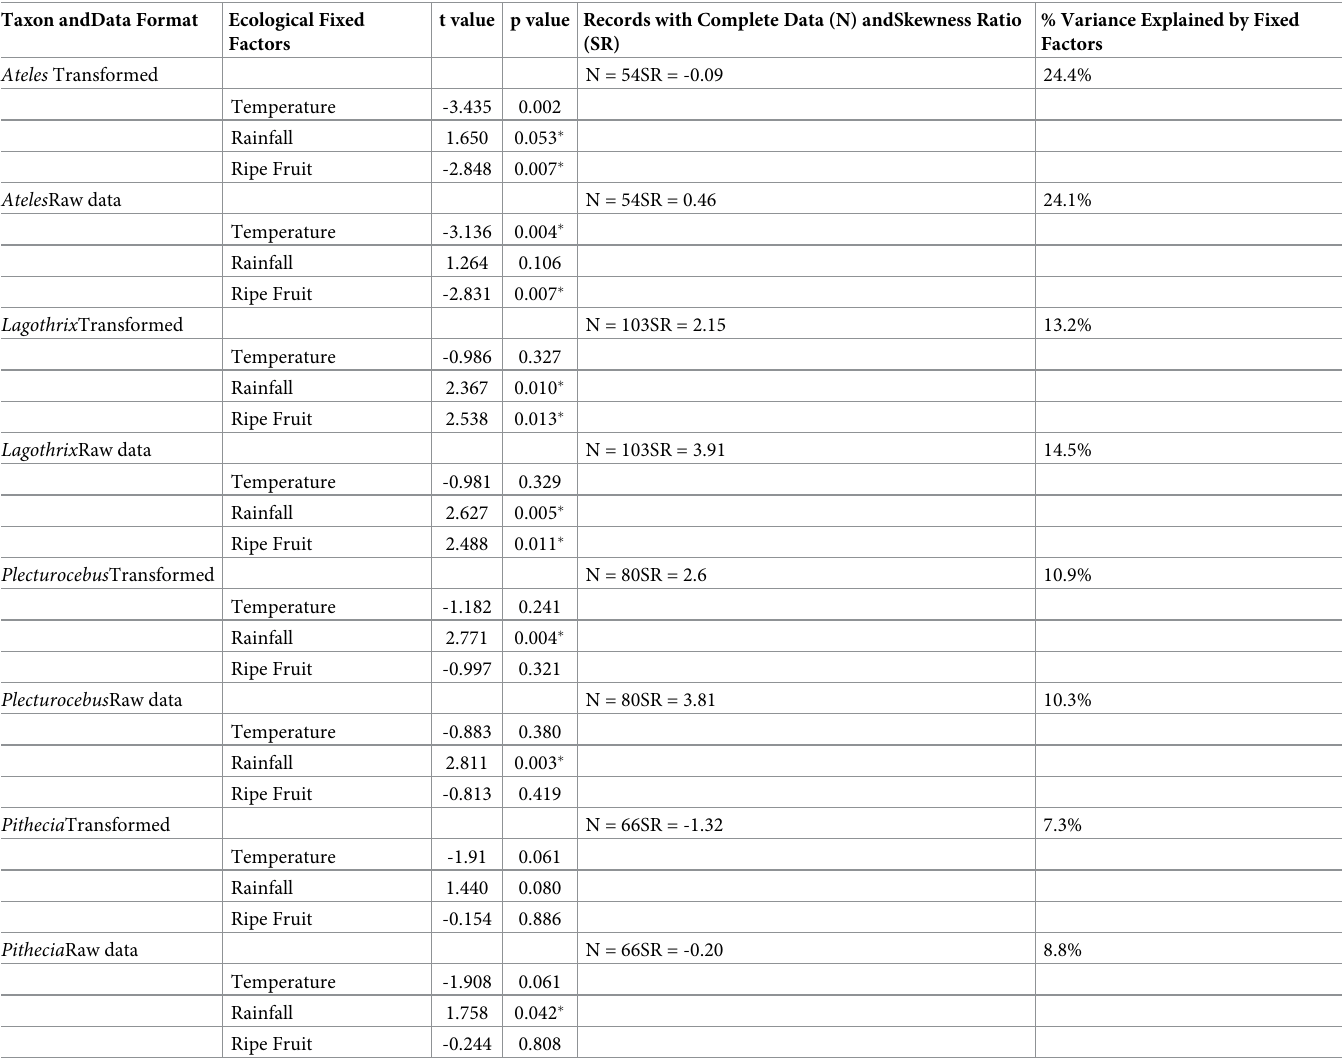
Table 6. Analyses of associations between timing of first feeding bouts and ecological